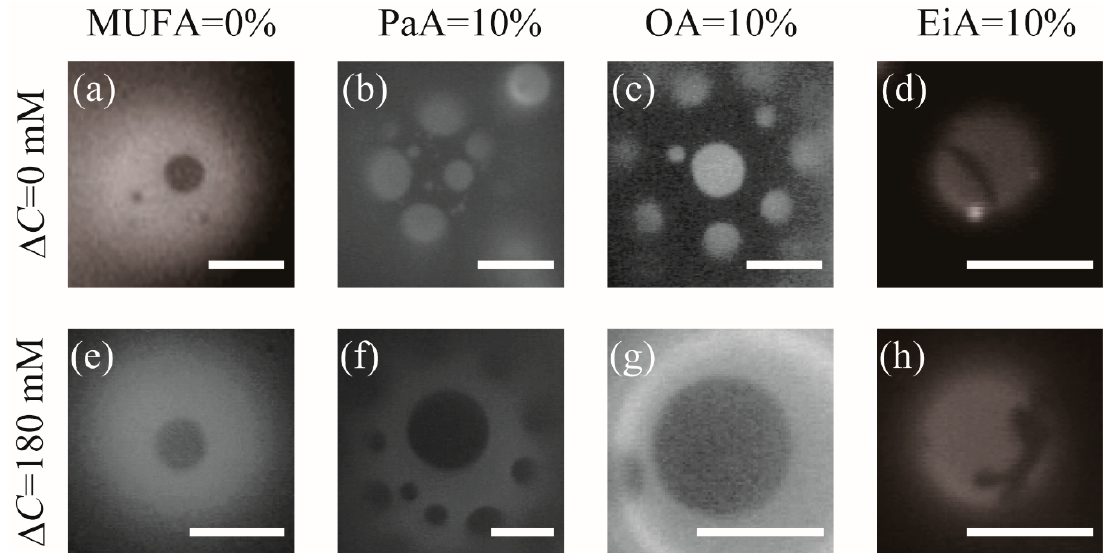
Figure 1. Phase separation observed by fluorescence microscopy for DOPC/DPPC/MUFA/Chol: ( a , e ) 40/40/0/20, ( b , f ) 30/40/10/20 (MUFA = PaA), ( c , g ) 30/40/10/20 (MUFA = OA), and ( d , h ) 30/40/10/20 (MUFA = EiA). The upper ( a – d ) and lower ( e – h ) rows are the images at Δ C = 0 (without osmotic stress) and 180 mM (with osmotic stress), respectively. Scale bars are 5 μ m.